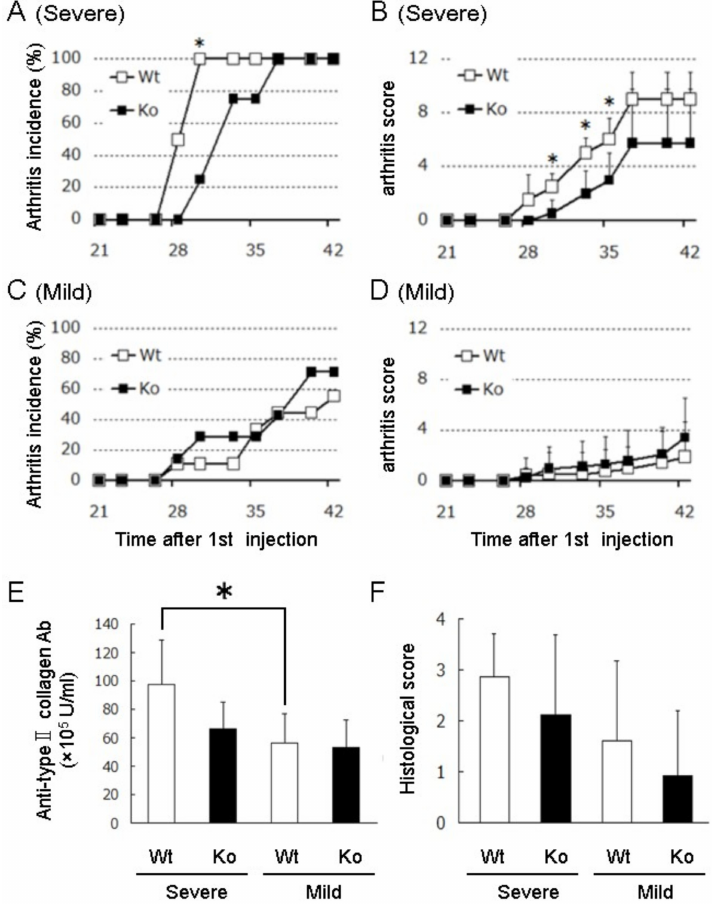
Figure 2. Incidence of arthritis ( A,C ) and mean arthritis score ( B,D ) in SPACIA1 -deficient (ko) or wt mice injected with “Severe” or “Mild” collagen II (CII) are shown (wt; n = 4, ko; n = 5 ( A,B ), wt; n = 9, ko; n = 7 ( C,D )). Data points and error bars correspond to the mean and SD,